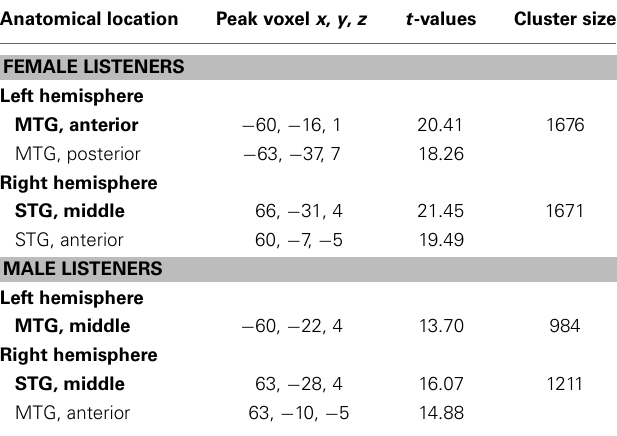
Table 2 | Voice-sensitive peak voxels of female and male group analysis